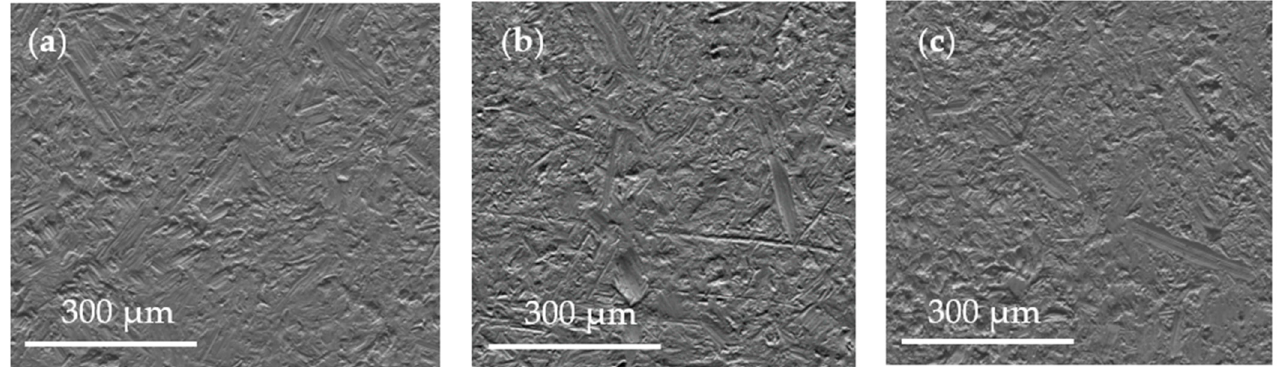
Figure 11. Images of the sample surface, obtained with SEM, after 45 min of smoothing: without movement ( a ); with rotational movement ( b ); with rotation and oscillating movement ( c ).